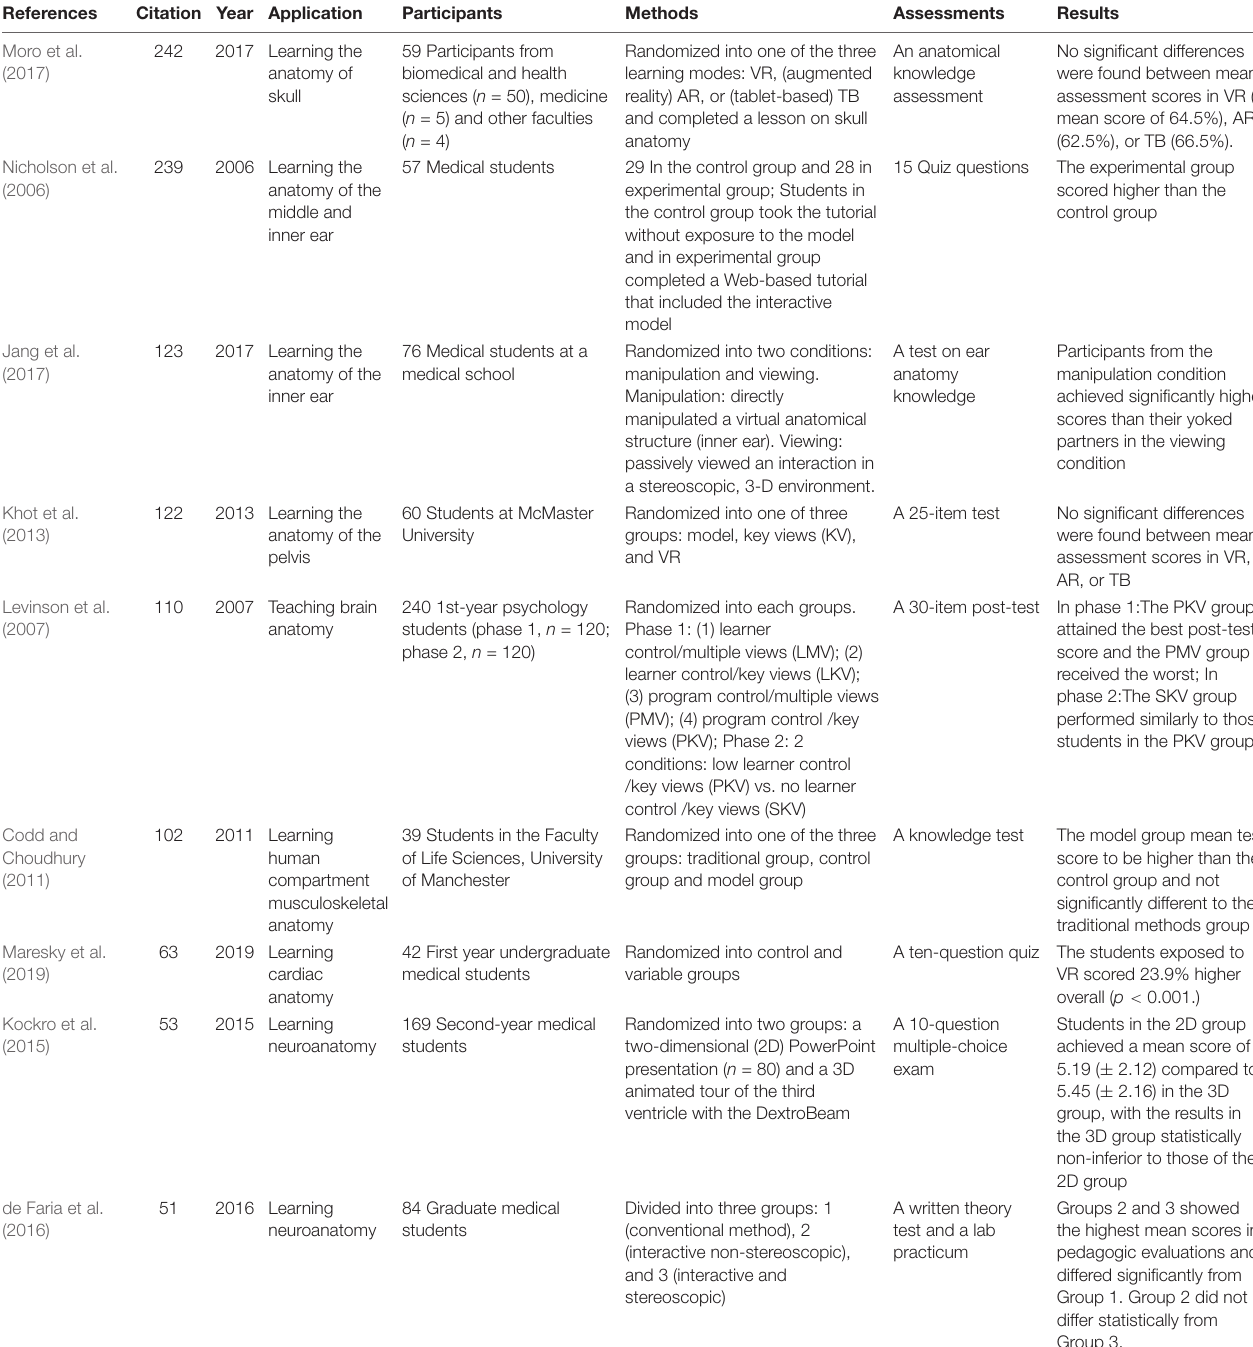
TABLE 1 | Summary table of published studies applying virtual reality in anatomy